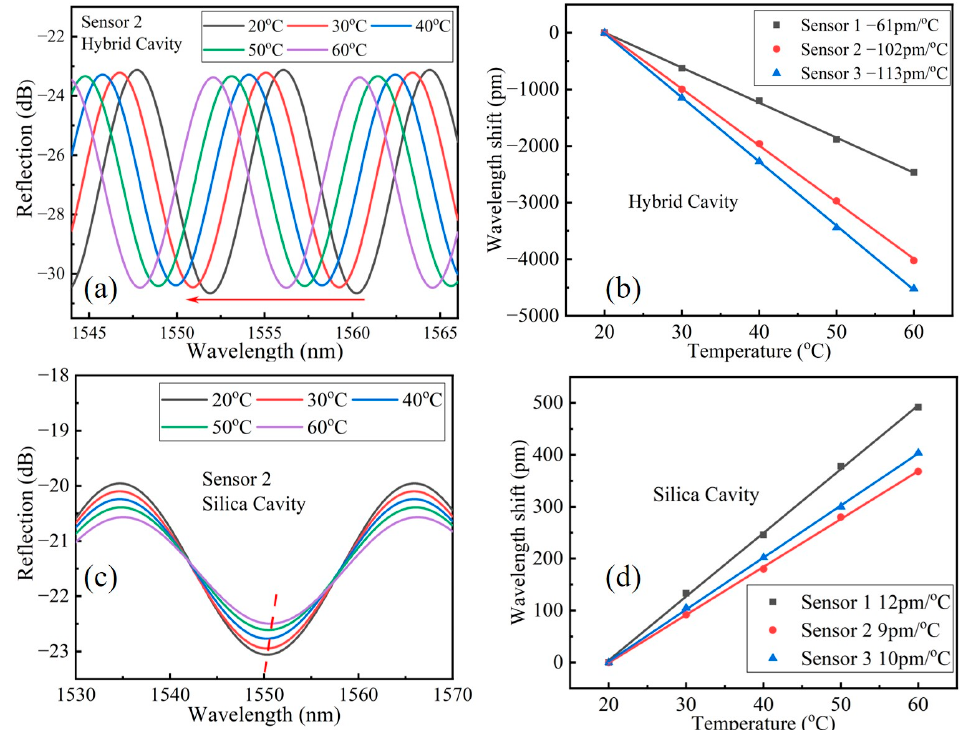
Figure 8. ( a , c )The extracted spectra of the hybrid cavity and silica cavity of S2 under di ff erent tem- Figure 8. ( a , c ) The extracted spectra of the hybrid cavity and silica cavity of S2 under different perature, respectively; ( b , d ) The linear fi tt ing of resonant wavelength shift of the hybrid cavity and temperature, respectively; ( b , d ) The linear fitting of resonant wavelength shift of the hybrid cavity silica cavity toward temperature of S1, S2 and S3, respectively. and silica cavity toward temperature of S1, S2 and S3,